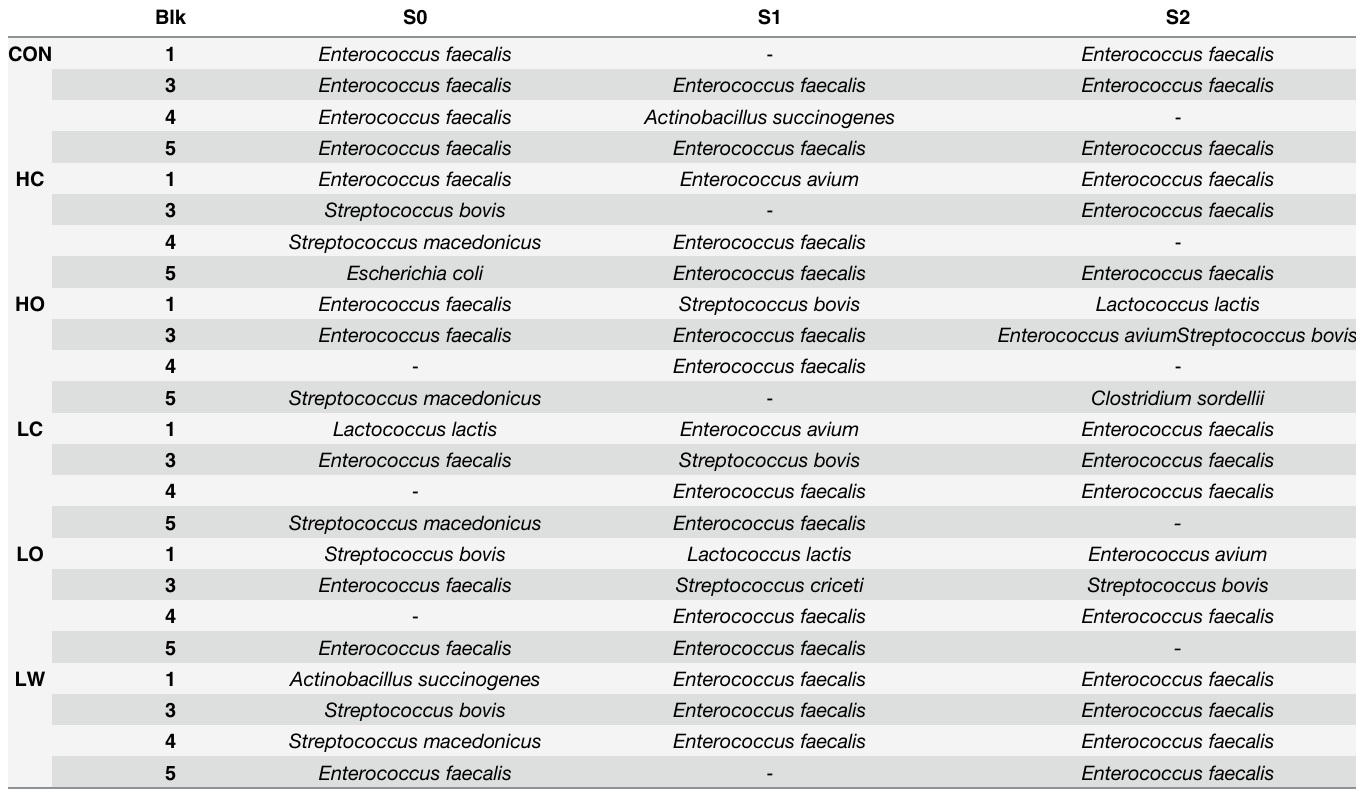
Table 4. Closest phylogenetic relative of the equine amylolytic bacteria isolates ( > 97% 16S gene sequence